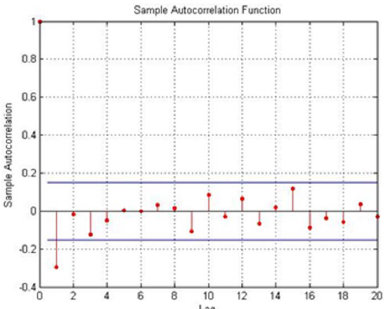
Figure 1. Autocorrelation function that satisfies the conditions.